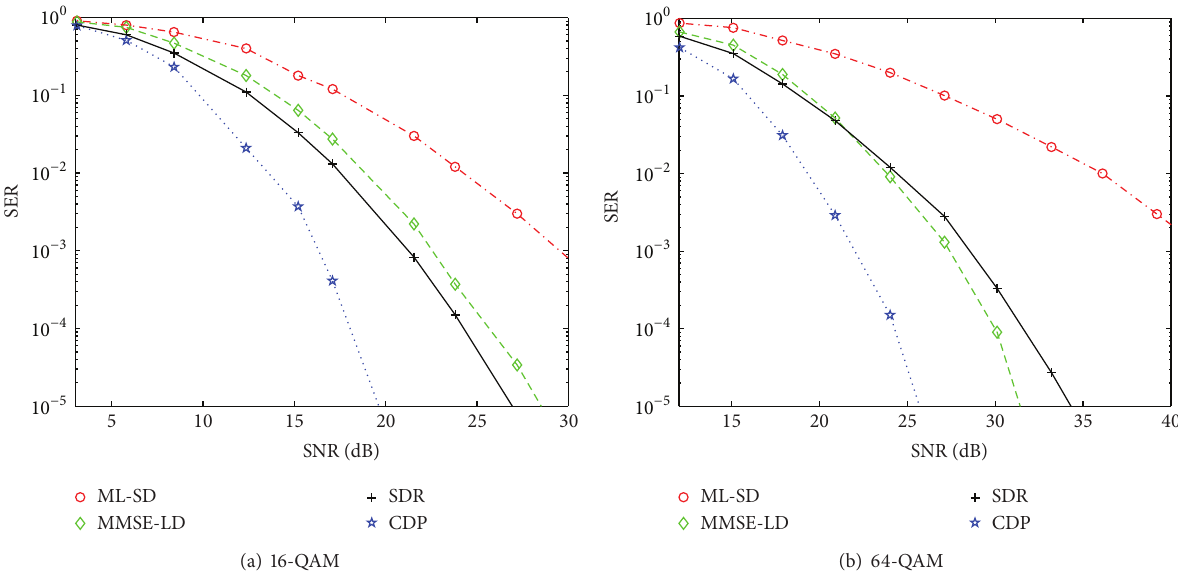
Figure 1: Symbol error rate comparison for different methods, (𝑚,𝑛) = (8,8) .